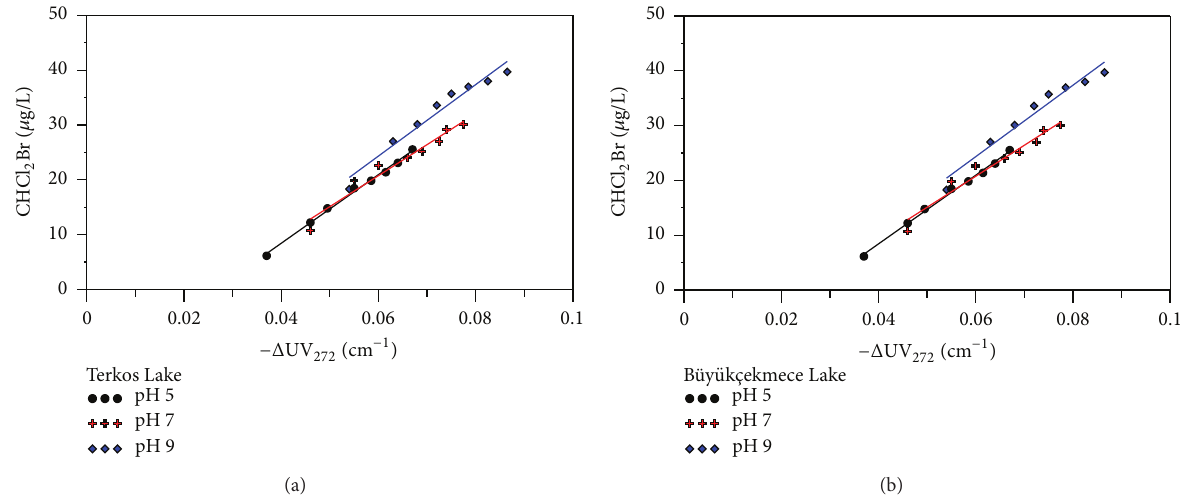
Figure 5: The relationship between CHCl 2 Br and Δ UV 272 at different pH (pH 5, pH7, and pH 9) and Cl 2 to DOC ratios from 0.8 to 3.2 (a) for in chlorinated TL water and (b) for in chlorinated BL water.